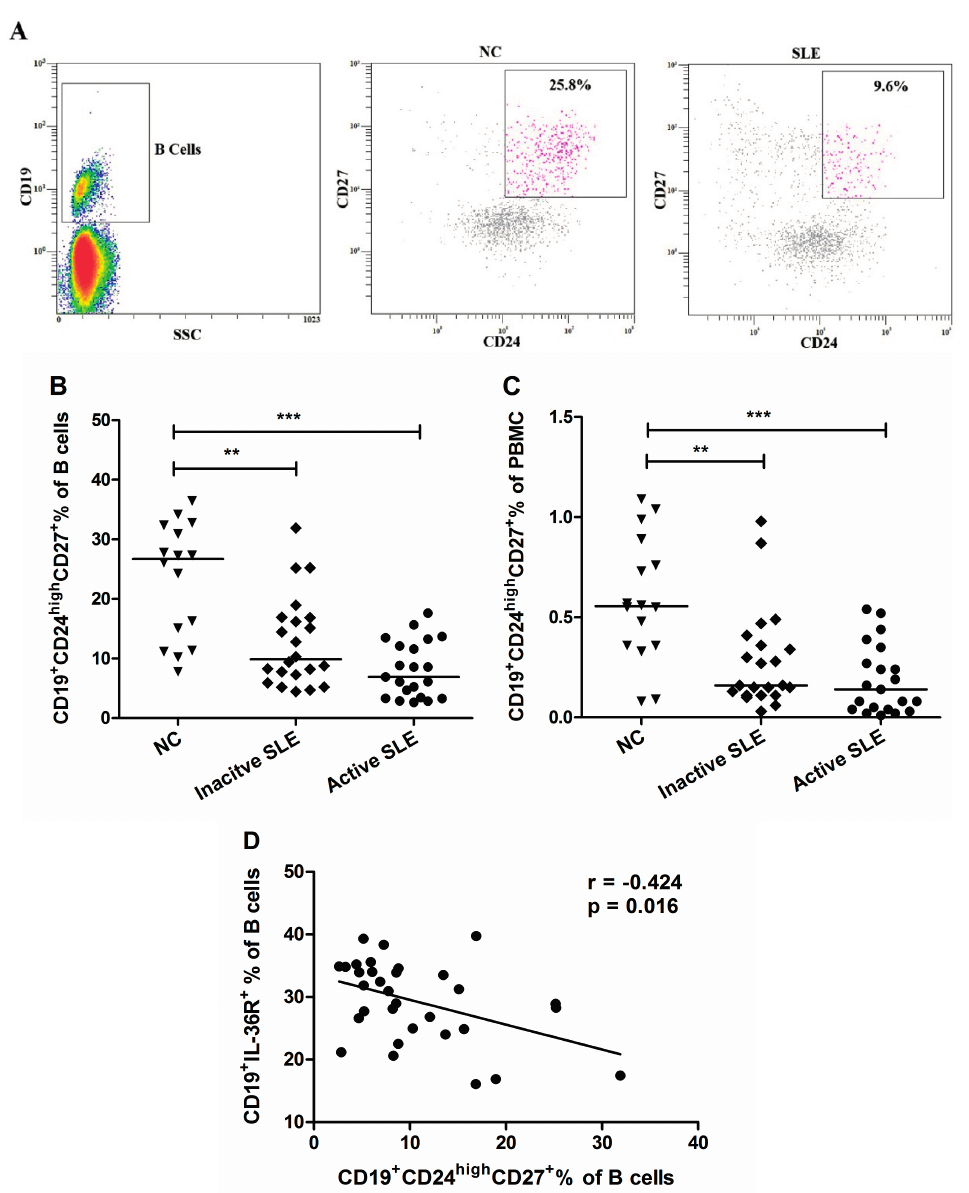
Figure 4 . Comparison of circulating CD19 + CD24 high CD27 + Breg lymphocytes frequency between SLE patients and NC. ( A ) Representative dot plots are shown for the CD19 + CD24 high CD27 + Breg lymphocytes gated from CD19 + B cells in SLE patients and NC; ( B , C ) The proportion of circulating Breg lymphocytes from inactive ( n = 22) and active ( n = 21) SLE patients and NC ( n = 16) in total B cells and in PBMC were determined by flow cytometry. Results are presented as scatter plots with median. ( D ) Correlation between % CD19 + IL-36R + B cells and % CD19 + CD24 high CD27 + Breg cells was analyzed with Spearman’s test. Statistical significances are indicated by ** p < 0.01 and *** p < 0.001 when compared with NC (Mann-Whitney U